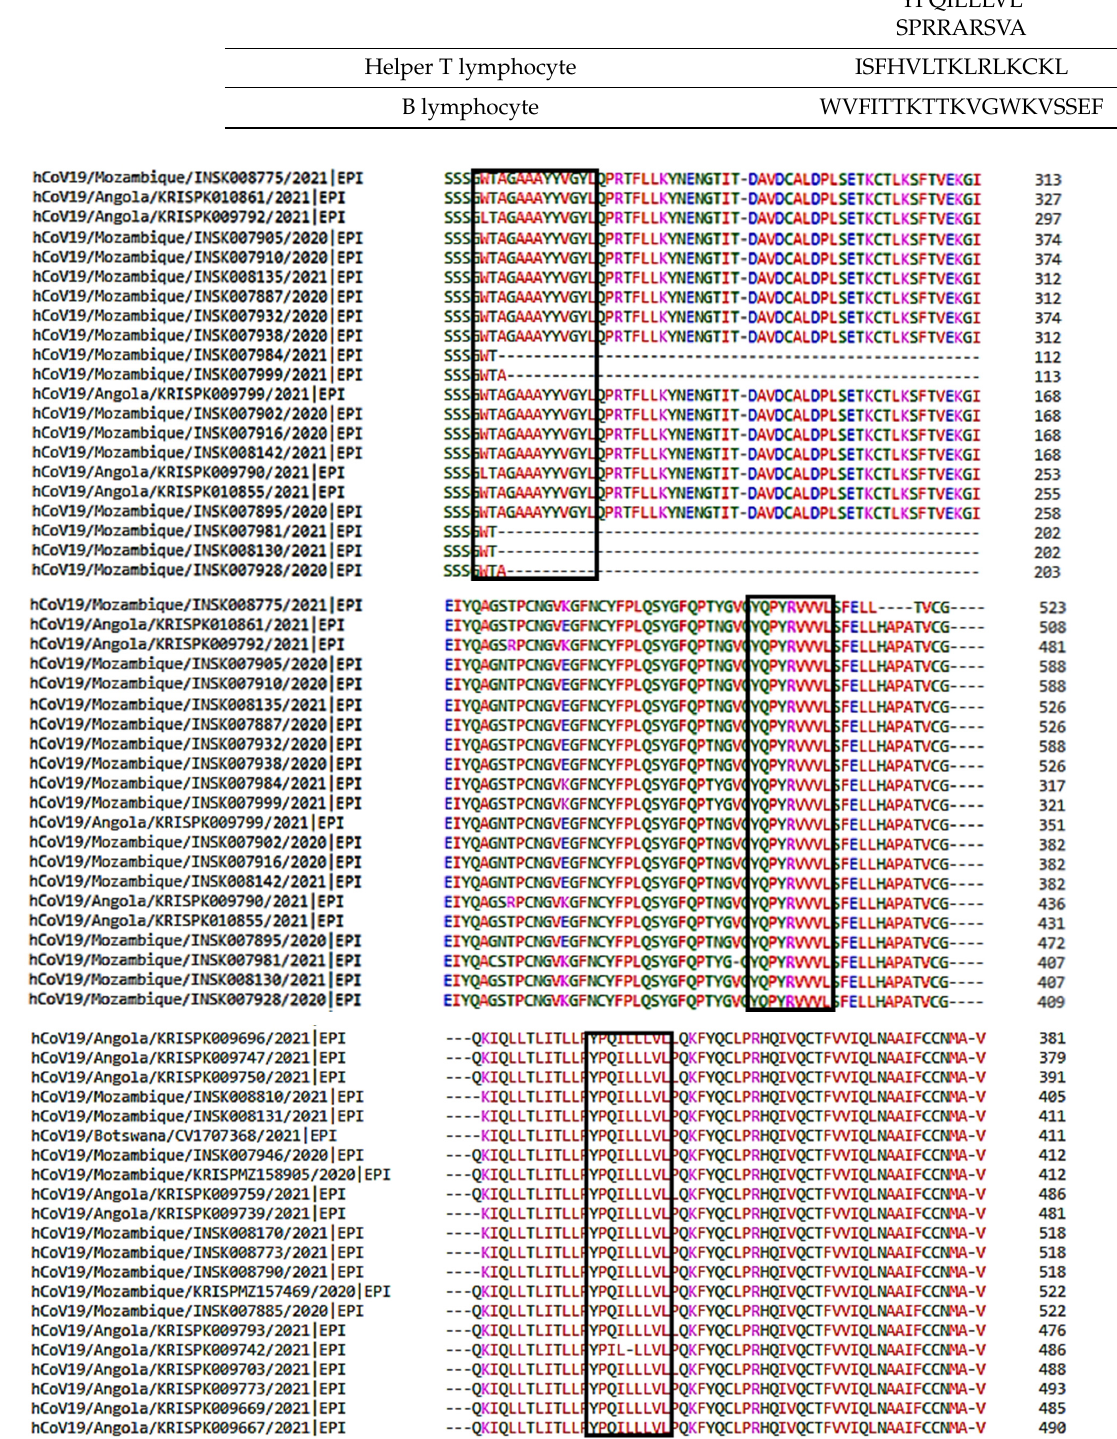
Figure 2. Multiple sequence alignment of spike glycoprotein sequences. The epitope sequences selected for vaccine design have been identified by boxes.